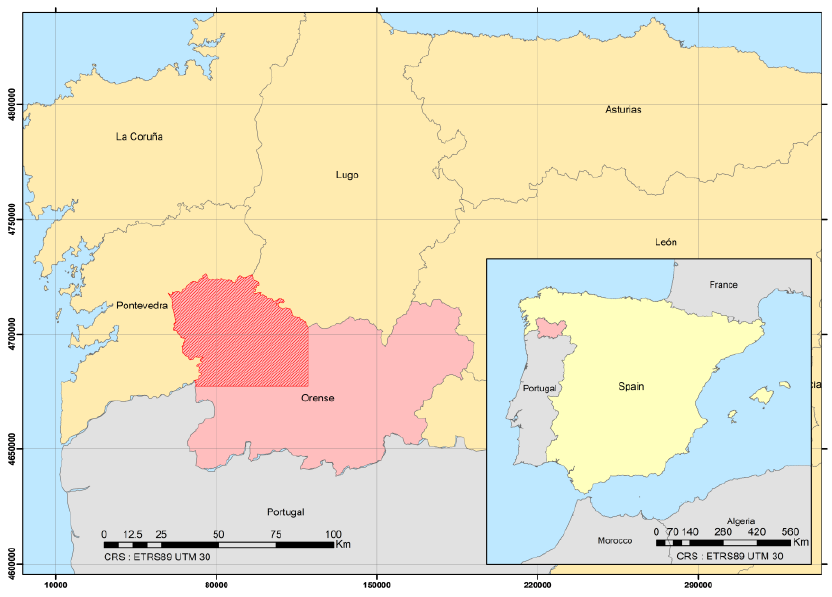
Figure 4. Location of study case. The study area is highlighted in red stripes.